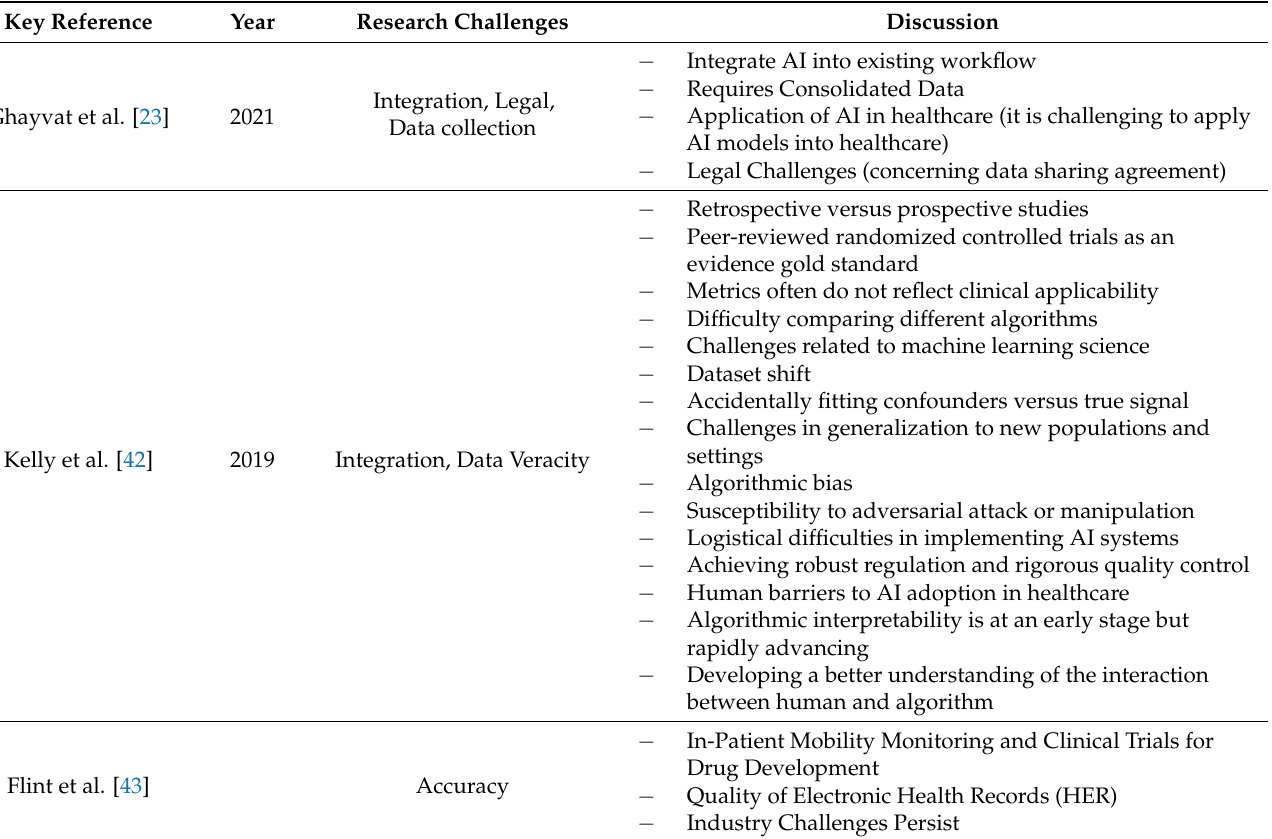
Table 3. A list of Key Challenges in AI in